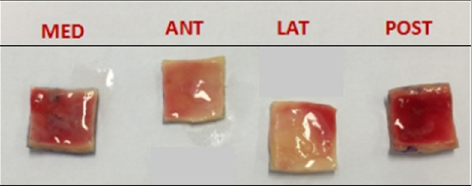
Fig 6. Section of aorta sample with square shape (size: 15 mm � 15 mm). One specimen by